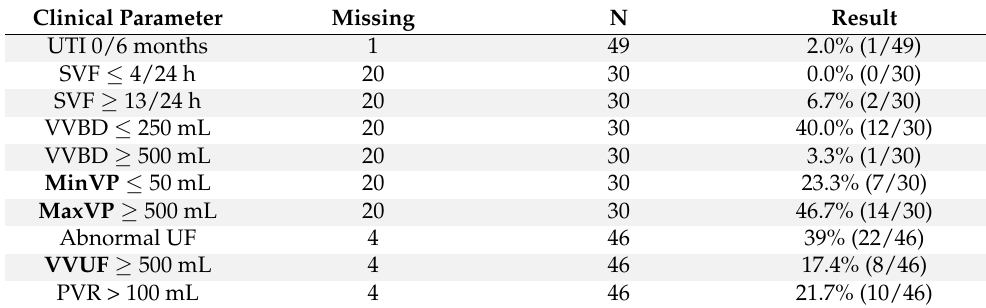
Table 2. Distribution of the clinical parameters in the asymptomatic patient cohort. Clinical Parameter Missing